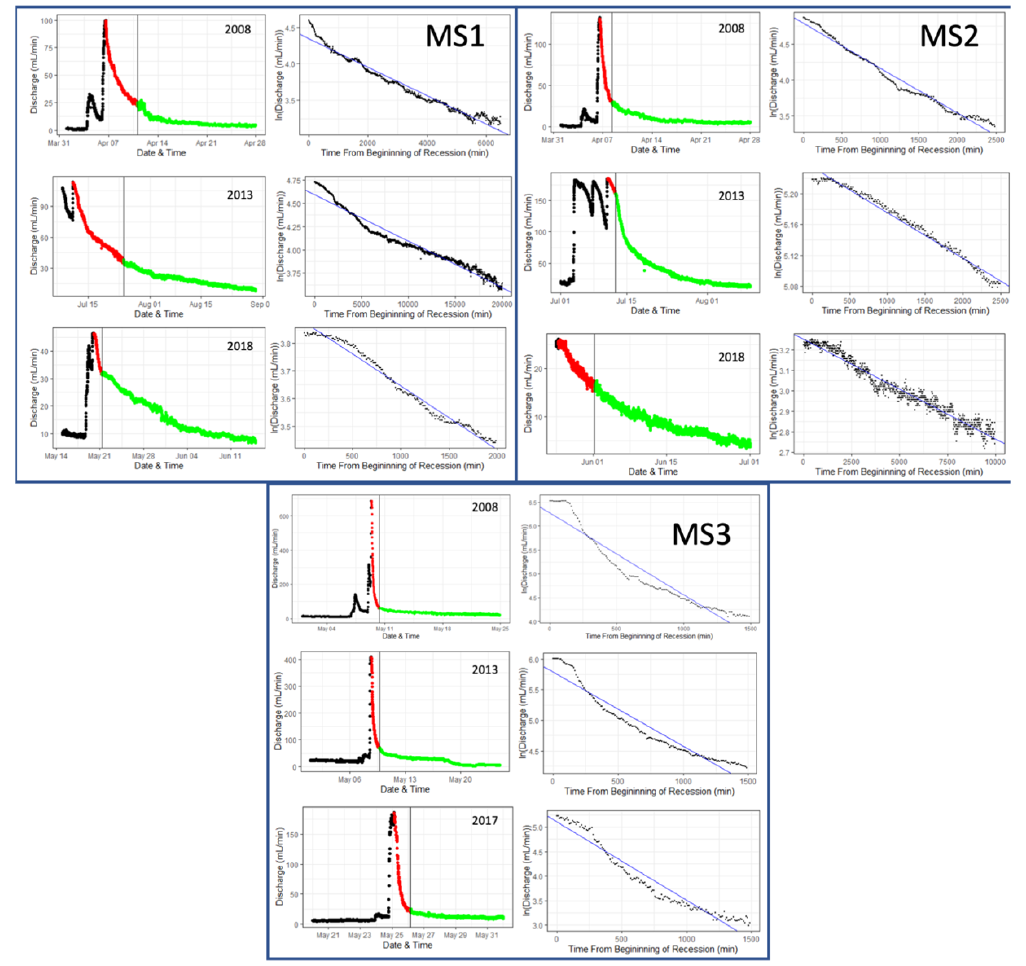
Figure 5. Individual hydrographs for drip sites MS1, MS2 and MS3. Red segment shows first reces- sion segment; green shows second recession segment. The log discharge on the right shows the fit used to calculate α 1 from the first recession segment. Table 4. Storage volumes (L) and α values calculated for drip hydrographs f or MS1, MS2 and MS3 using Equation (5). V 1 and a 1 reflect diffuse flow from epikarst; V 2 and α 1 reflect diffuse flow from epikarst. Also shown is the % rapid (concentrated) flow and % diffuse (base) flow for each hydro- graph, using Equation (5) and the assumptions outlined in the text. Grey shaded regions reflect periods of recharge.